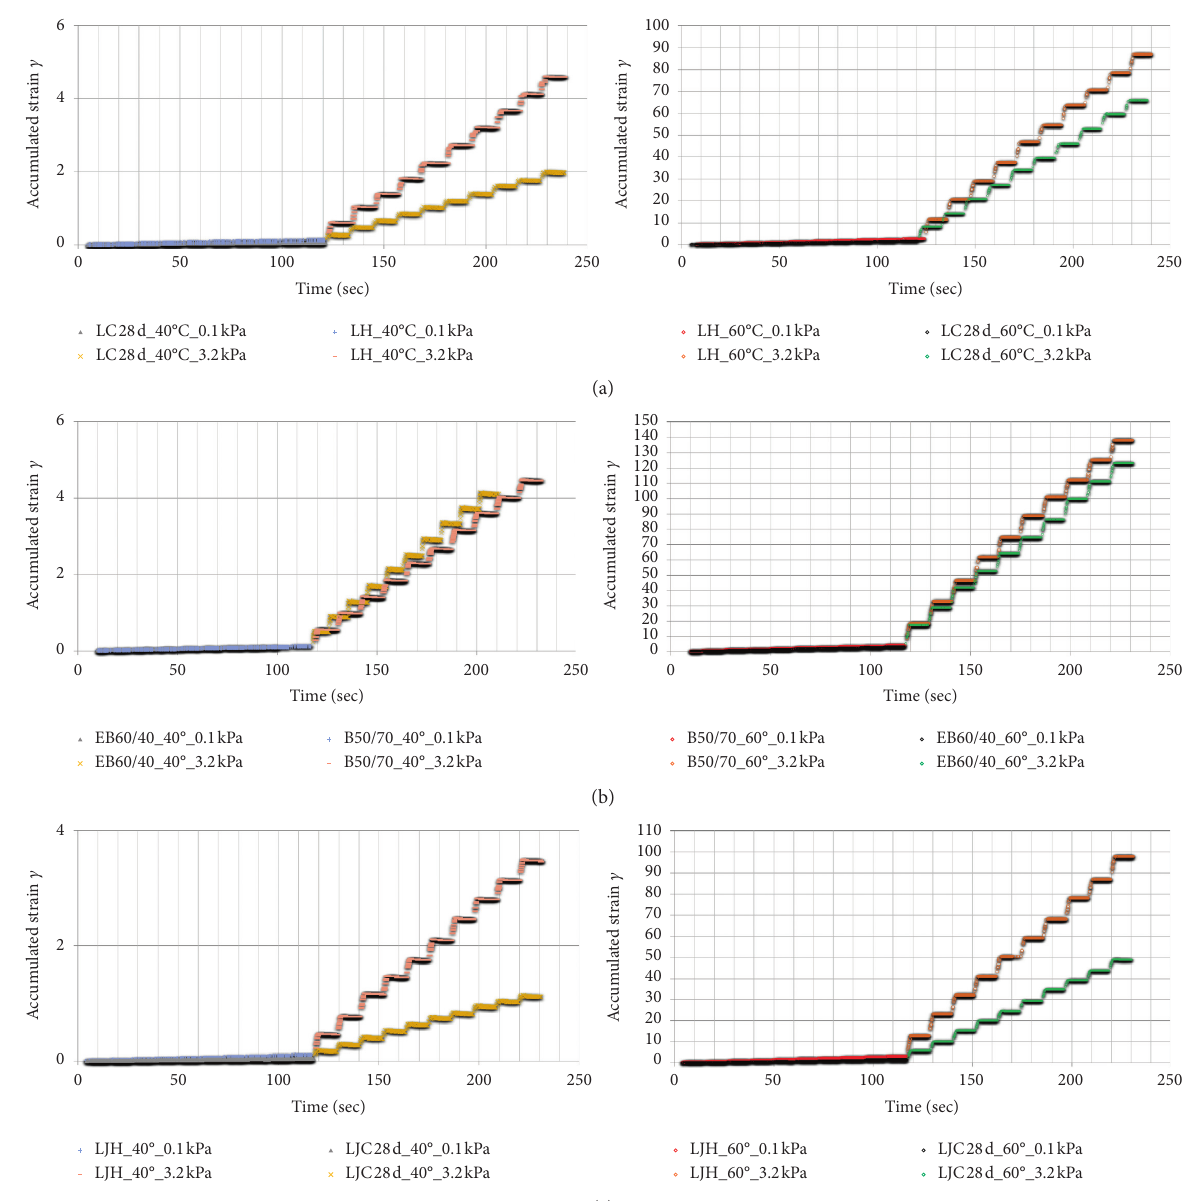
Figure 12: Accumulated strain results at the end of every 10 creep-recovery cycles of hot and cold bituminous mastics: (a) LH vs LC28d (I at 40 ° C and II at 60 ° C), (b) JH vs JC28d (I at 40 ° C and II at 60 ° C), and (c) LJH vs LJC28d (I at 40 ° C and II at 60 °